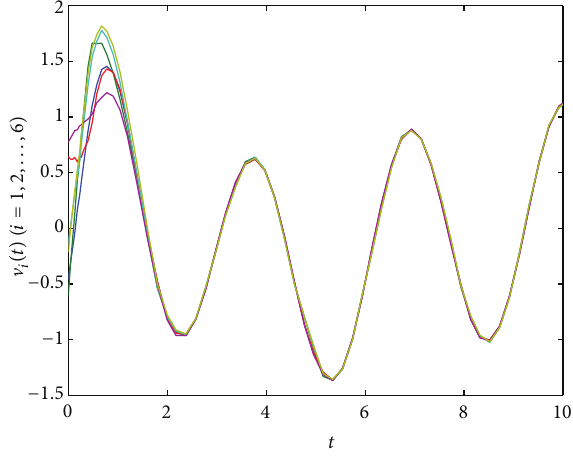
Figure 3: The velocity curves V 𝑖 (𝑡) (𝑖 = 1,2,...,6) for nonlinear multiagent systems (43) with 𝜏 0 = 0 , 𝜏 1 = 0.3